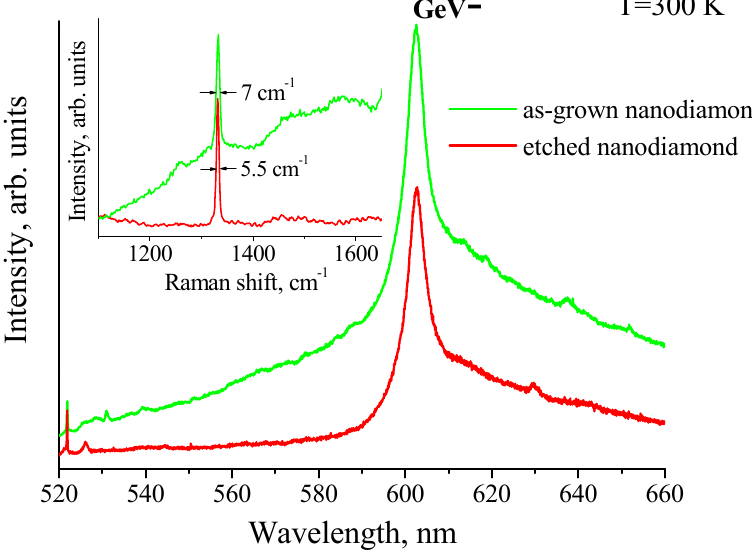
Figure 2. Typical photoluminescence spectra of as-grown nanodiamonds (green) and etched nanodiamonds (red) measured at T = 300 K. The inset shows Raman spectra of the nanodiamonds; the bandwidths of ~1332 cm − 1 diamond band are shown.